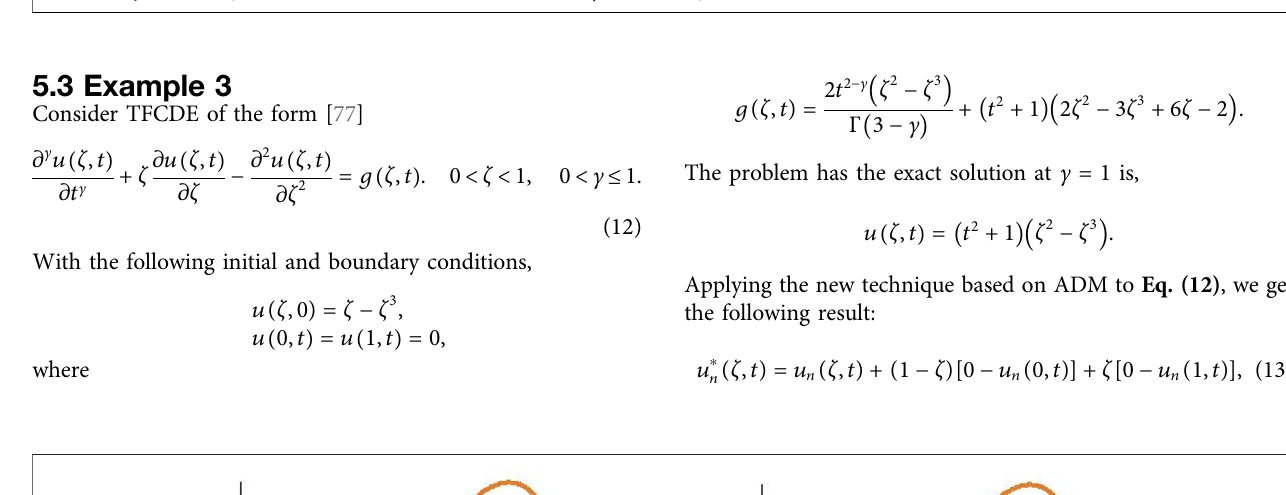
FIGURE 8 | 3D and 2D plots for the ADM solution at different values of γ =1 for Example 2.